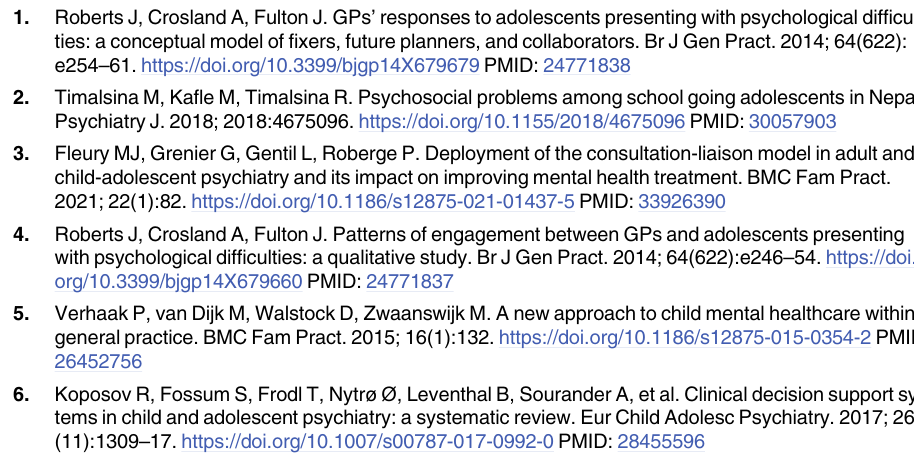
S1 Fig. Interviews connections (family)codes and quotes [in